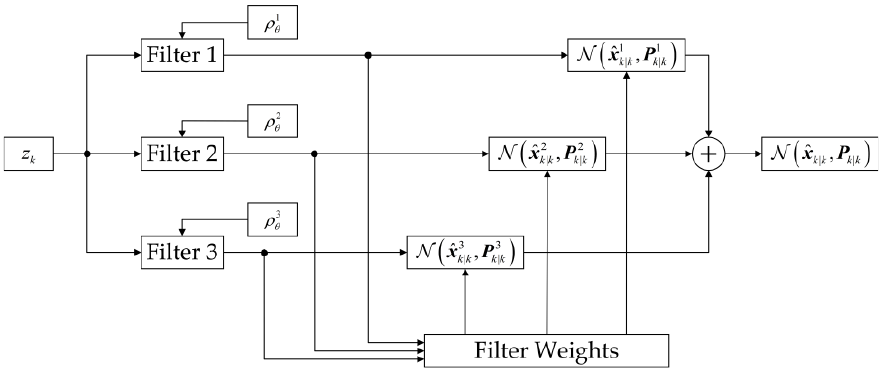
Figure 6. Structure of the IMM estimator.